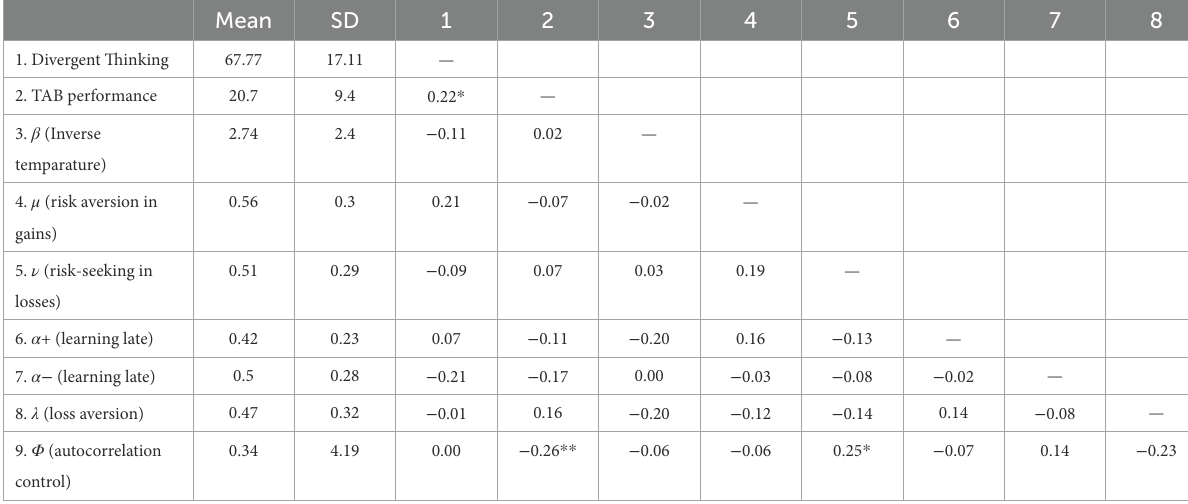
TABLE 1D Descriptive statistics